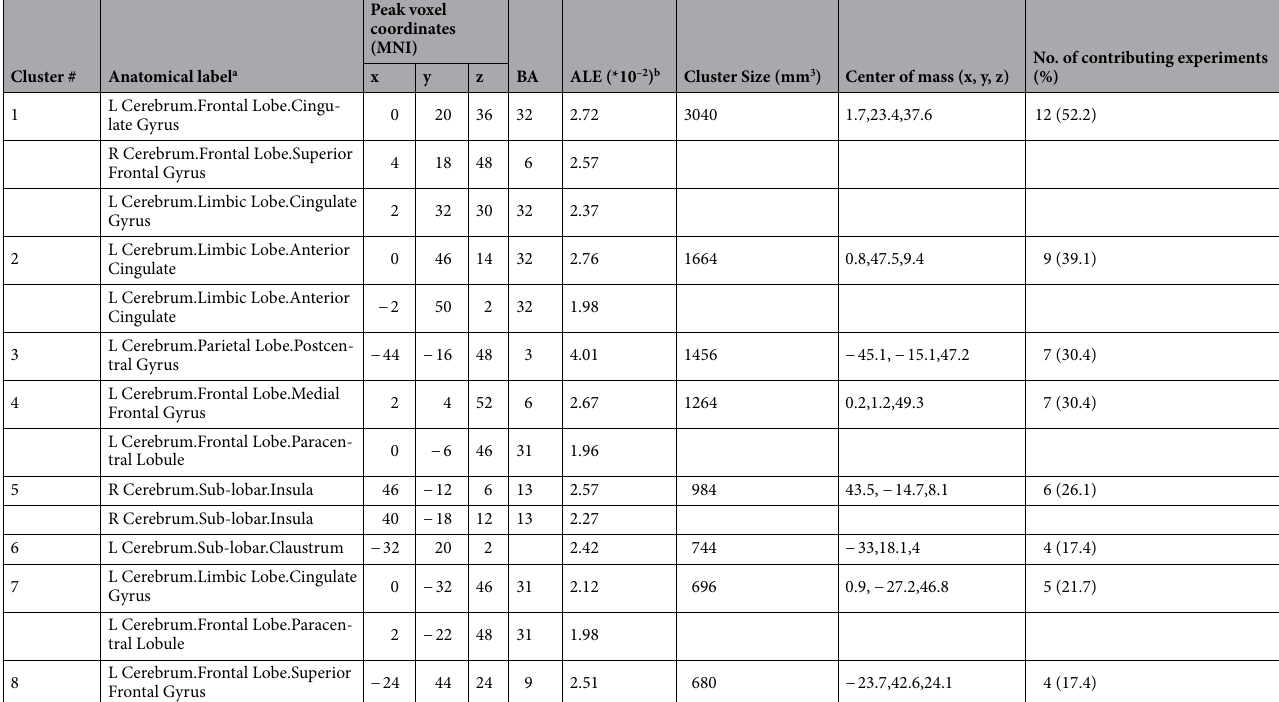
Table 2. ALE clusters significant after cluster-level FWE correction for multiple comparisons. BA, brodman area; L, left hemisphere; R, right hemisphere; x, y, z coordinates provided in MNI space. a Anatomical labelling according to Talairach Daemon (nearest gray matter within 5 mm, talairach.org) associated with the peak coordinates after icbm2tal transformation. b Maximum ALE value observed in the